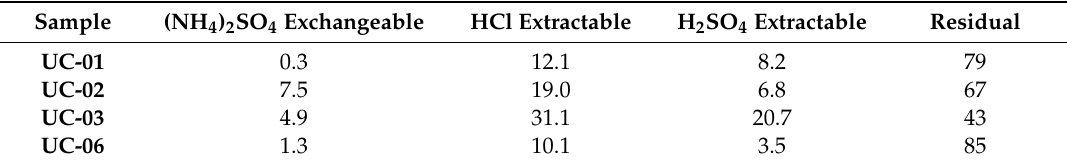
Table 7. Fraction of REE in pregnant leach solution (PLS) from sequential digestion of